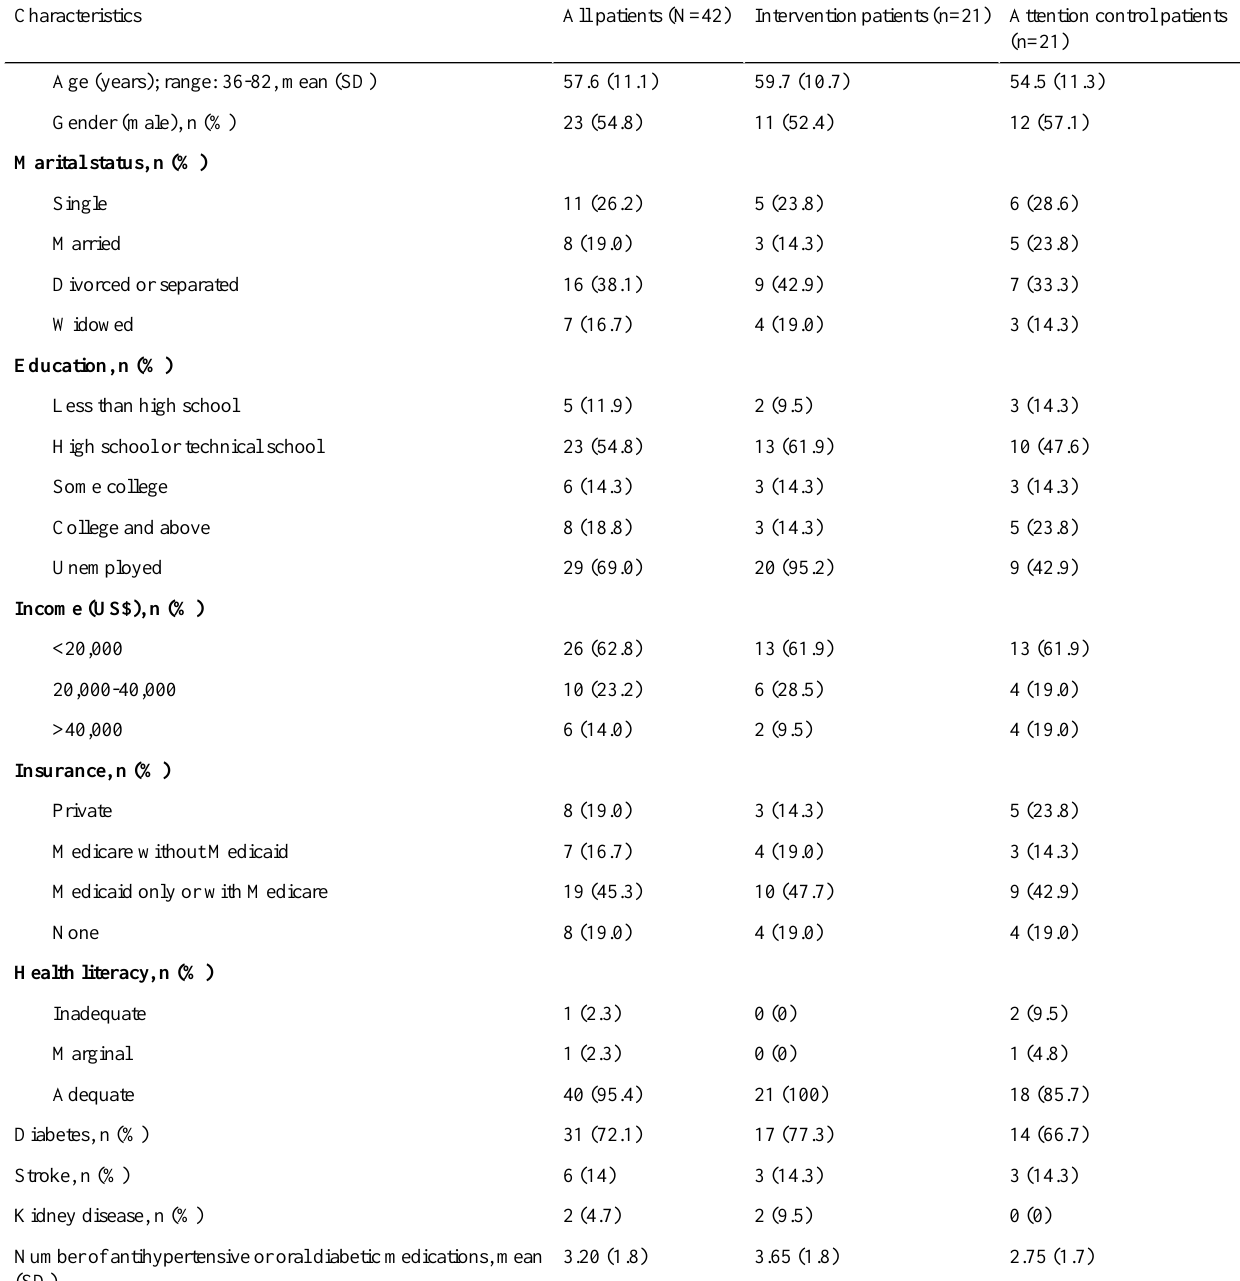
Table 2. Baseline sociodemographic characteristics for all patients and by study